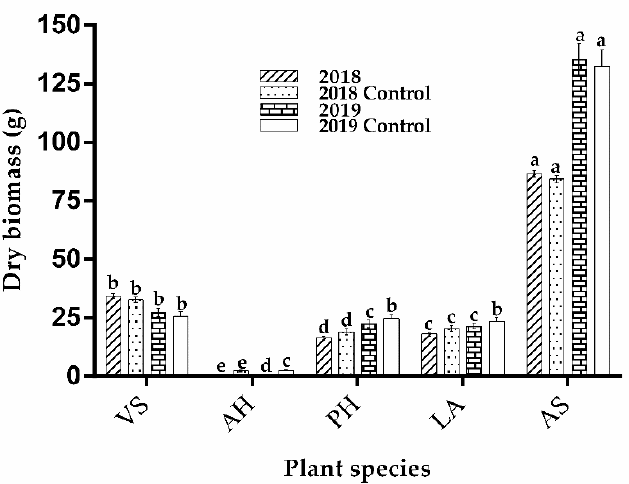
Figure 3. Aboveground dry biomass per plant measured at the end of each growing season for the five species: VS: Vicia sativa L., AH: Asparagus horridus L., PH: Peganum harmala L., LA: Launaea arborescens (Batt.) Murb., and AS: Atriplex semibaccata R. Br. Note: Different letters above columns of different plant species indicate significant differences ( p < 0.05).